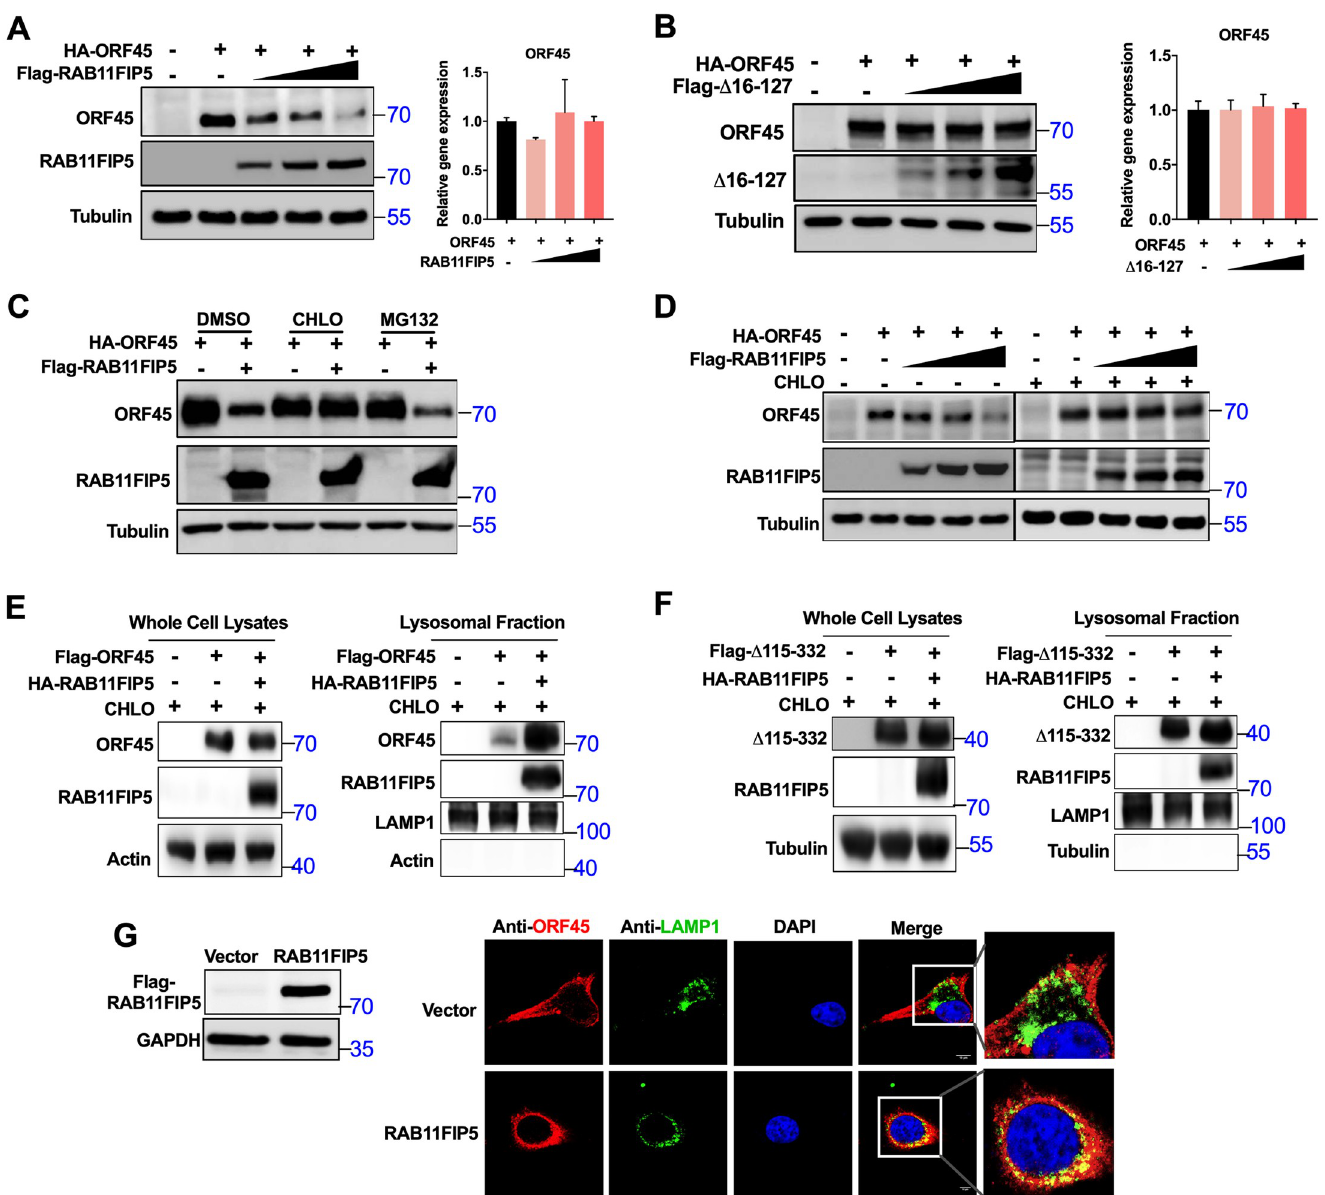
Fig 6. RAB11FIP5 promotes lysosomal degradation of ORF45. (A) Effect of RAB11FIP5 on ORF45 expression. HEK293T cells were cotransfected with 1 μ g of ORF45 expression plasmid and increasing amounts of RAB11FIP5 expression vector (0, 0.5, 1, and 2 μ g). ORF45 protein expression was assessed by immunoblotting with the indicated antibodies. ORF45 mRNA was detected using RT-qPCR with the indicated primers. (B) Effect of the RAB11FIP5 C2 domain deletion mutant ( Δ 16– 127) on ORF45 expression. HEK293T cells were cotransfected with 1 μ g of ORF45 expression plasmid and increasing amounts of the Δ 16–127 expression vector (0, 0.5, 1, and 2 μ g). ORF45 protein expression was assessed by immunoblotting. ORF45 mRNA was detected using RT-qPCR with the indicated primers. (C) Effects of inhibitors on RAB11FIP5-mediated destabilization of ORF45. HEK293T cells were transfected with the indicated plasmids. Fourteen hours after transfection, cells were treated with the indicated inhibitors for 6 h before immunoblot analysis was performed. (D) HEK293T cells were transiently cotransfected with HA-ORF45 and increasing amounts of Flag-RAB11FIP5 (0, 0.5, 1, and 2 μ g). ORF45 protein expression was examined by western blotting in the presence and absence of CHLO. (E) HEK293T cells were transfected with Flag-ORF45 alone or cotransfected with Flag-ORF45 and HA-RAB11FIP5 for 36 h and were then treated with CHLO for another 6 h. A portion of cell samples for whole cell lysis was subjected to western blotting with the indicated antibodies (left panel). The lysosomal fraction was isolated from the remaining cell samples and subjected to western blotting with the indicated antibodies (right panel). (F) HEK293T cells were transfected with ORF45 deletion mutant Flag- Δ 115–332 alone or cotransfected with Flag- Δ 115–332 and HA-RAB11FIP5 for 36 h and were then treated with CHLO for another 6 h. A portion of cell samples for whole cell lysis was subjected to western blotting with the indicated antibodies (left panel). The lysosomal fraction was isolated from the remaining cell samples and subjected to western blotting with the indicated antibodies (right panel). (G) Stable clones of HeLa-RAB11FIP5 and HeLa-Vector cells were isolated and expanded from the monoclonal cell population by using the limiting dilution method. The expression of RAB11FIP5 was confirmed by western blotting. To assess the